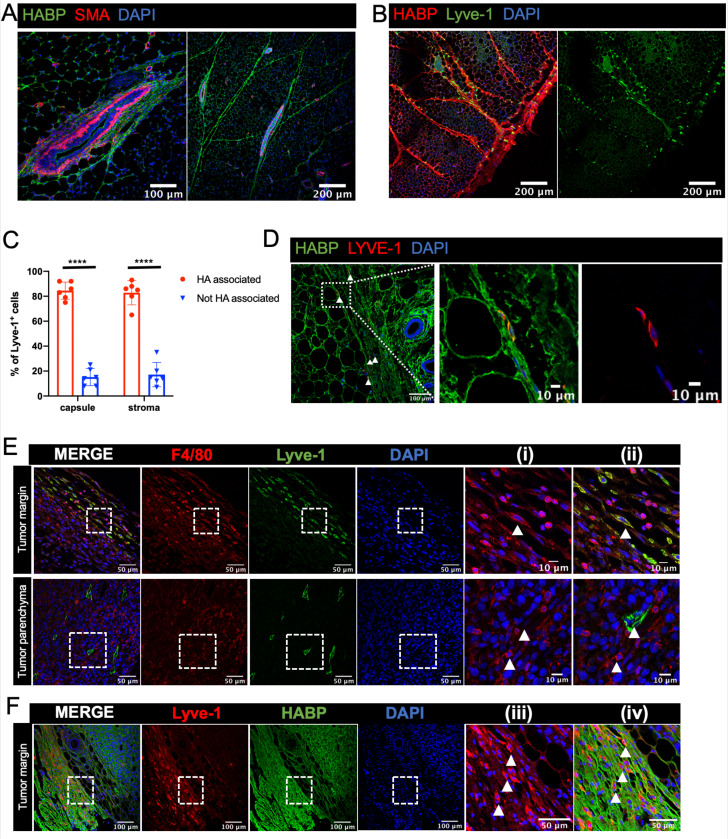
Lyve-1+ cells localize to HA-enriched ECM in the mammary gland.(A) Mammary glands from 6-week-old mice were immunostained for HA using HA binding protein (HABP, green) and smooth muscle actin (SMA, red) (n = 3, three images/sample). (B) Mammary glands from 6-week-old mice were immunostained for HA using HA binding protein (HABP, red) and Lyve-1 (green) showing staining of the fibrous capsule and fibrous septae in the adipose stroma. (C) Quantification of Lyve-1+ cells associated with the capsule and adipose stromal regions in the mammary gland. N = 6 mice, three images analyzed per mammary gland. ****p<0.0001. (D) Co-staining of HABP and Lyve-1 in human mammary gland demonstrating the presence of HA-associated Lyve-1+ cells (n = 3, five images/sample). Arrowheads show Lyve-1+ cells and inserts show higher magnification. (E) Mammary tumor sections from 4T1 tumors were immunostained for F4/80 (red) and Lyve-1 (green) (n = 4, three images/localization). Representative images are shown of the peri-tumoral stroma and the tumor parenchyma. Inserts show higher magnification. (F) Mammary tumor sections from 4T1 tumors were immunostained for Lyve-1 (red) and HABP (green). Insets show higher magnification.Figure 5—source data 1.Source data for graph in panel C.